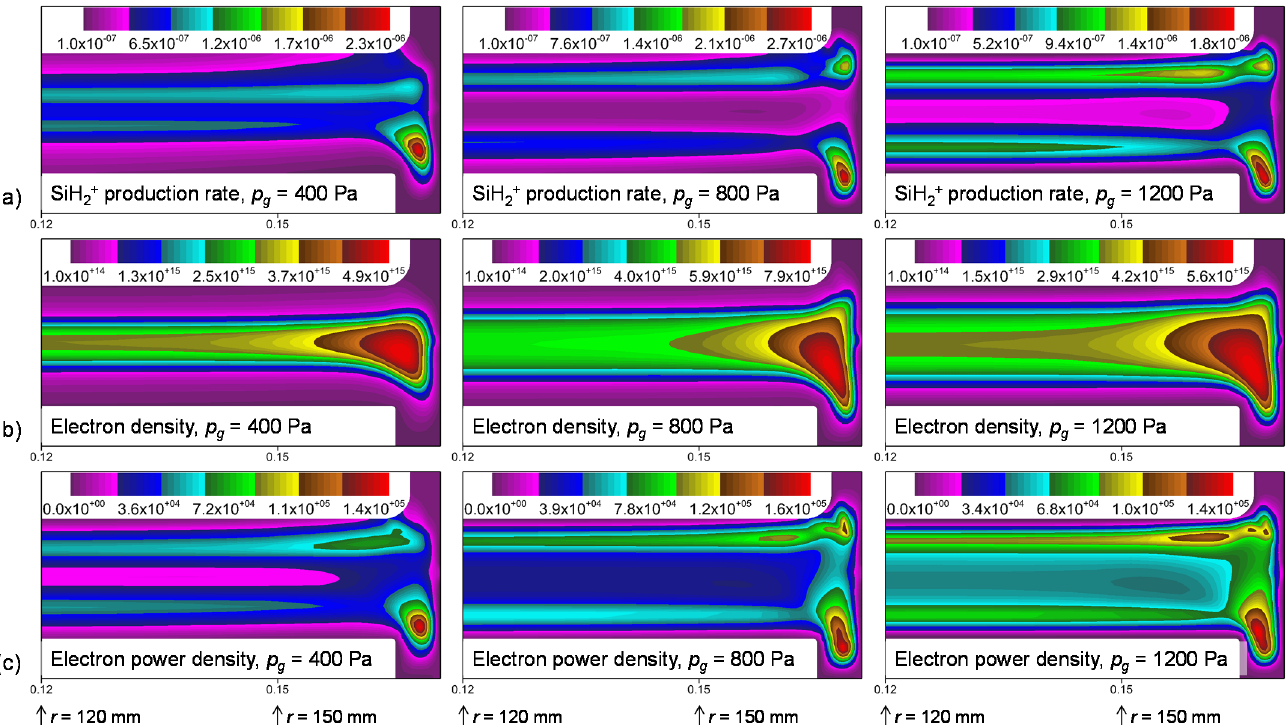
Figure 10. Effects of the gas pressure on the spatial distributions of plasma variables. Contour plots for the spatial profiles of the time-averaged ( a ) direct impact ionization rate (kmol m − 3 s − 1 ) for p g = 400, 800 and 1200 Pa, ( b ) electron density ( N e ; m − 3 ) for p g = 400, 800 and 1200 Pa, and ( c ) electron power density ( P e ; W m − 3 ) for p g = 400, 800 and 1200 Pa for r ≥ 120 mm.